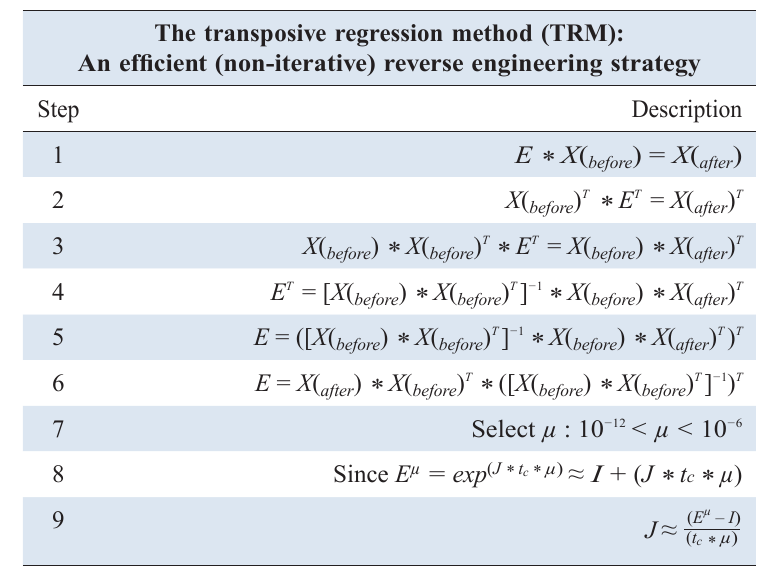
Table 4. In steps 1-2 recasting the problem by matrix transposition is essential. Steps 3-4 illustrate an application of the Moore-Penrose pseudoinverse, a widely known type of matrix pseudoinverse. In steps 5-6, retranspositions put E in proper order. In steps 7 a scaling factor µ is introduced to the product J * t c to scale down the product t c * µ to satisfy the condition specified in step 8. Finally, the unknown jacobian matrix may be ‘reverse engineered’ using the approximation method derived in step 9 as a result of the conditioning requirement satisfied in step